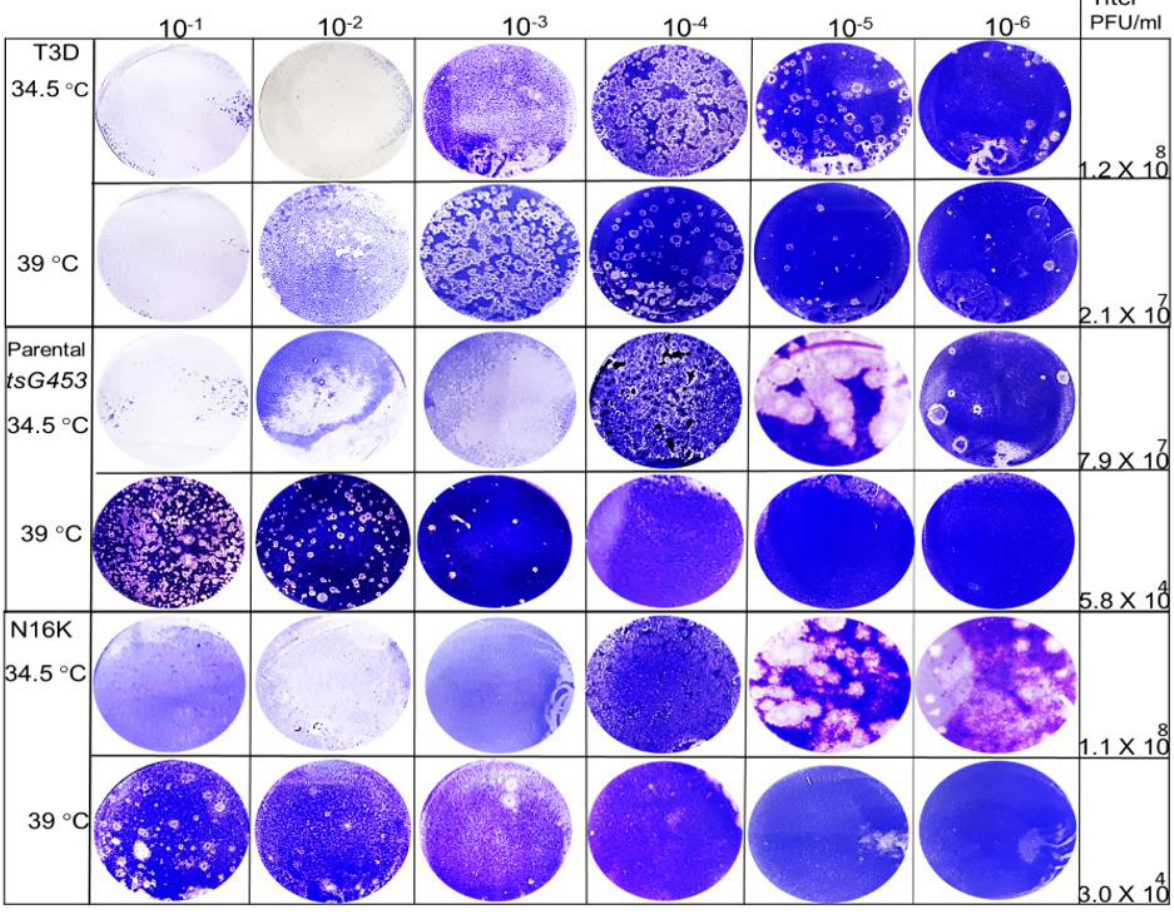
Figure 3. Viral plaques produced by various rescued isolates at 34.5 and 39 ◦ C. Ten-fold serial dilutions of P2 stocks for each isolate were adsorbed to mouse L929 monolayers and incubated for 5 days (39 ◦ C) or 8 days (34.5 ◦ C). Cell monolayers were fixed and stained with crystal violet.